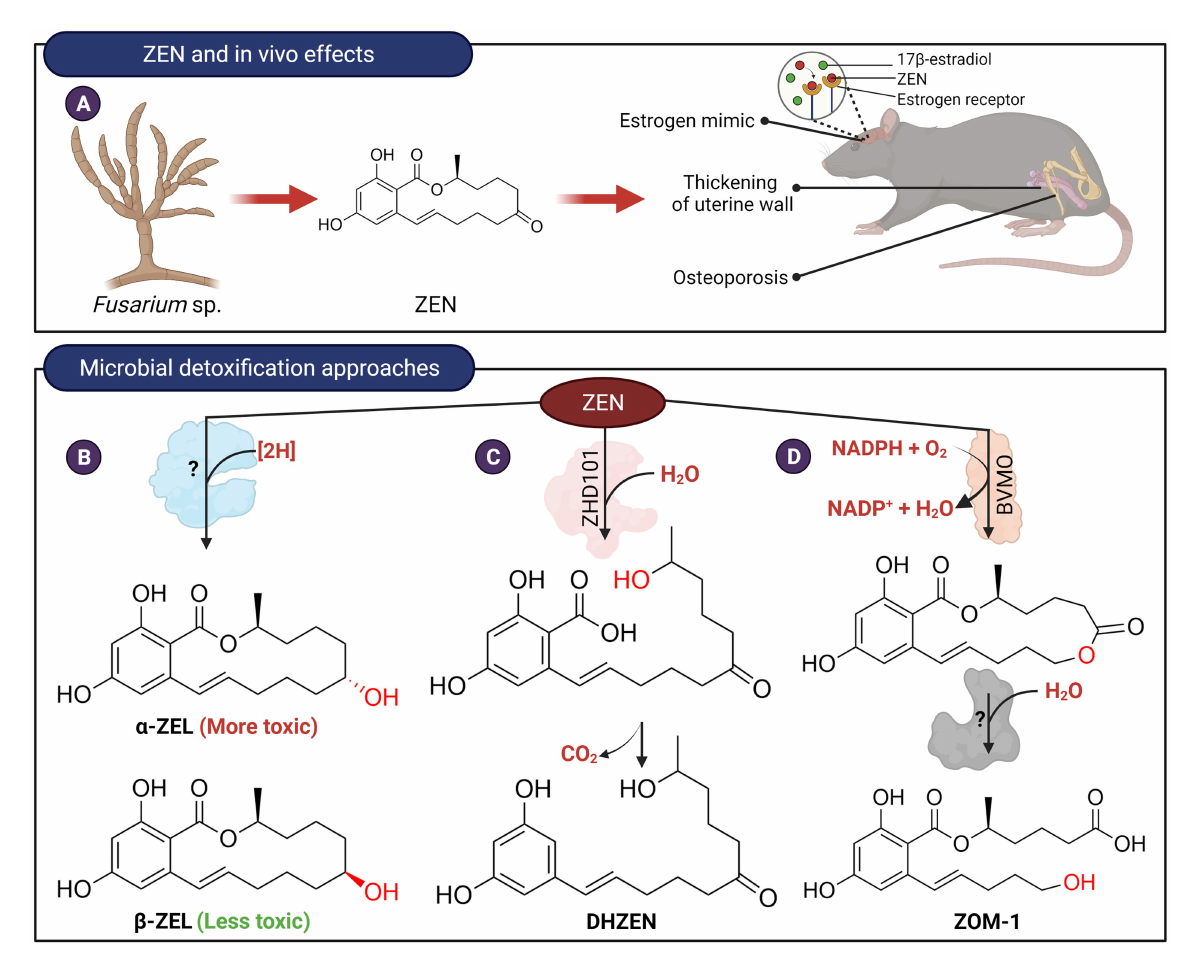
FIGURE 3 In vivo effects of ZEN and microbial detoxification approaches. (A) ZEN possesses estrogenic properties which in turn affect the endocrine and reproductive systems of animals. (B) Transformation of ZEN to α -ZEL or β -ZEL by microorganisms. The C7-carbonyl oxygen is reduced to an alcohol stereospecifically (red). The enzyme(s) responsible for catalyzing this reaction have not been isolated and identified. (C) ZEN can be hydrolyzed by lactone hydrolases followed by spontaneous decarboxylation to produce DHZEN. (D) Transformation of ZEN to ZOM-1 was postulated to occur in two steps. The first step could potentially be catalyzed by a Baeyer-Villiger type monooxygenase. The lactone product can then be hydrolyzed to